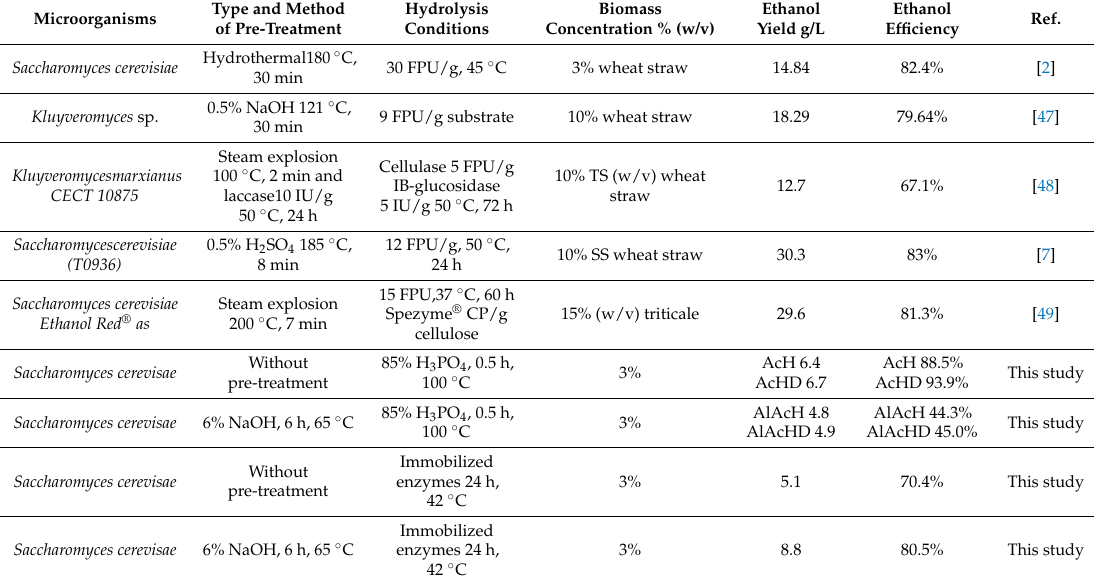
Table 9. Summary of investigations compared to other published